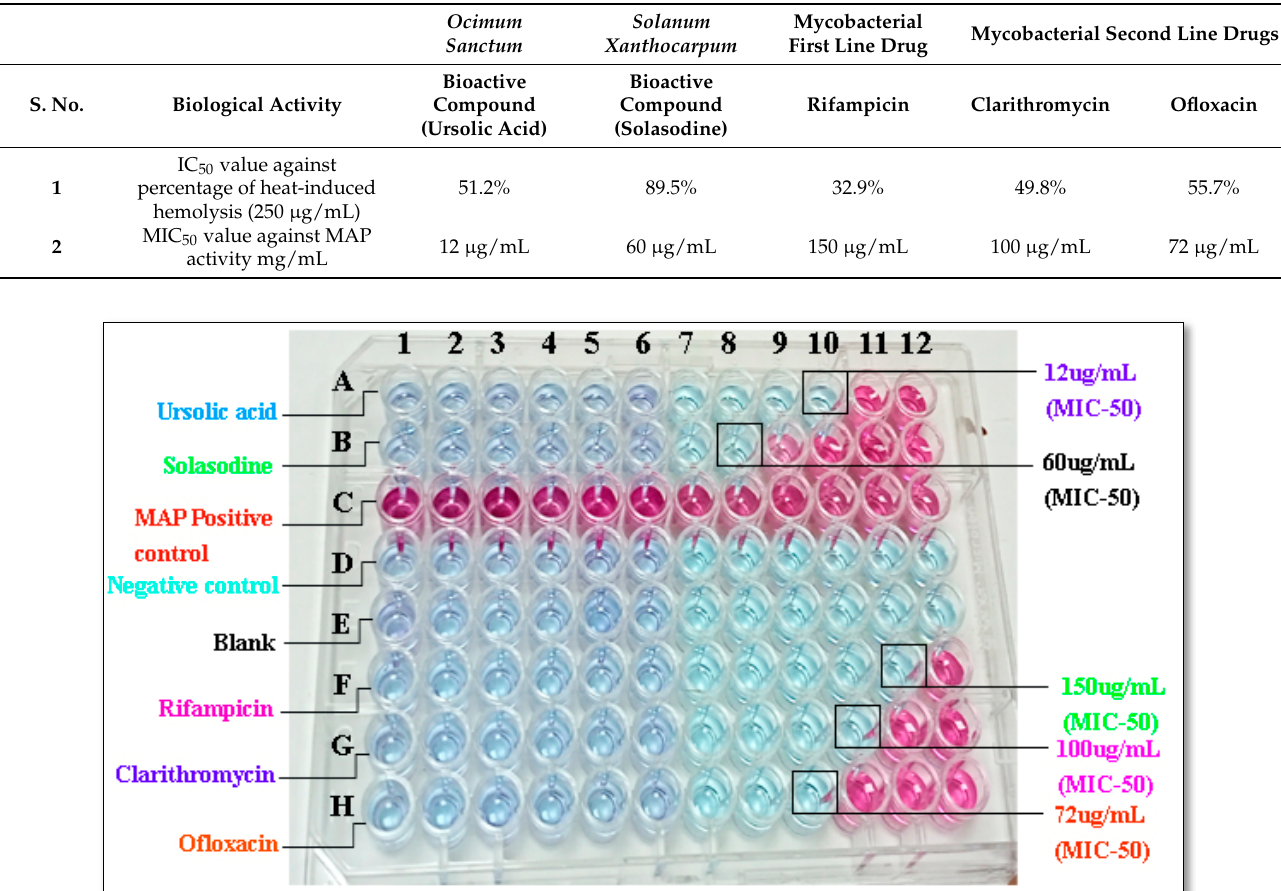
Figure 1. REMA assay. In vitro activity of bioactive compounds, i.e., Ursolic acid ( 12 µg/mL) and Solasodine (60 µg/mL), of Ocimum sanctum and Solanum xanthocarpum and Standard Solasodine (60 µ g/mL), of Ocimum sanctum and Solanum xanthocarpum and Standard anti-mycobacterial anti-mycobacterial first-and second-line drugs, i.e., Rifampicin (150 µg/mL), Clarithromycin (100 first-and second-line drugs, i.e., Rifampicin (150 µ g/mL), Clarithromycin (100 µ g/mL), and Ofloxacin µg/mL), and Ofloxacin (72 µg/mL). (72 µ